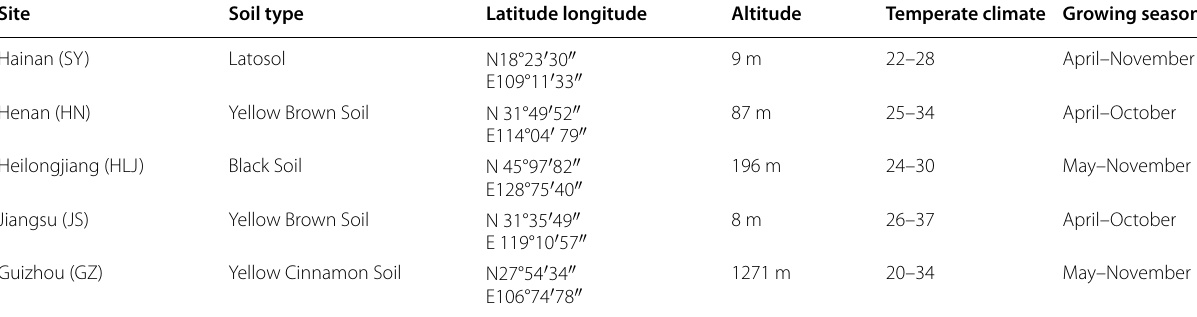
Soil types were classified according to China soil classification system (GB/T